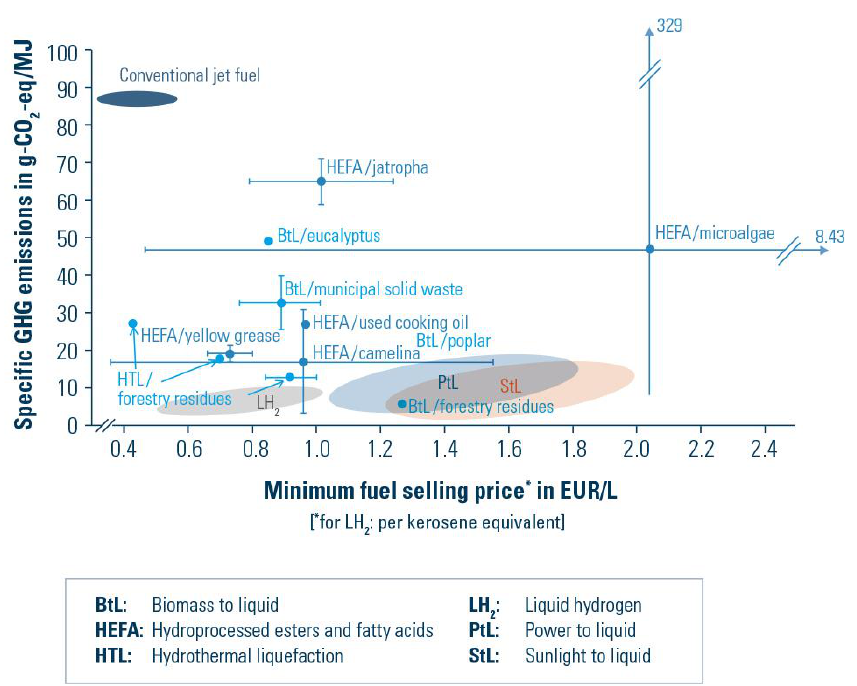
Figure 11. Comparison of cost estimates of various possible fuel / energy sources for aviation [17].